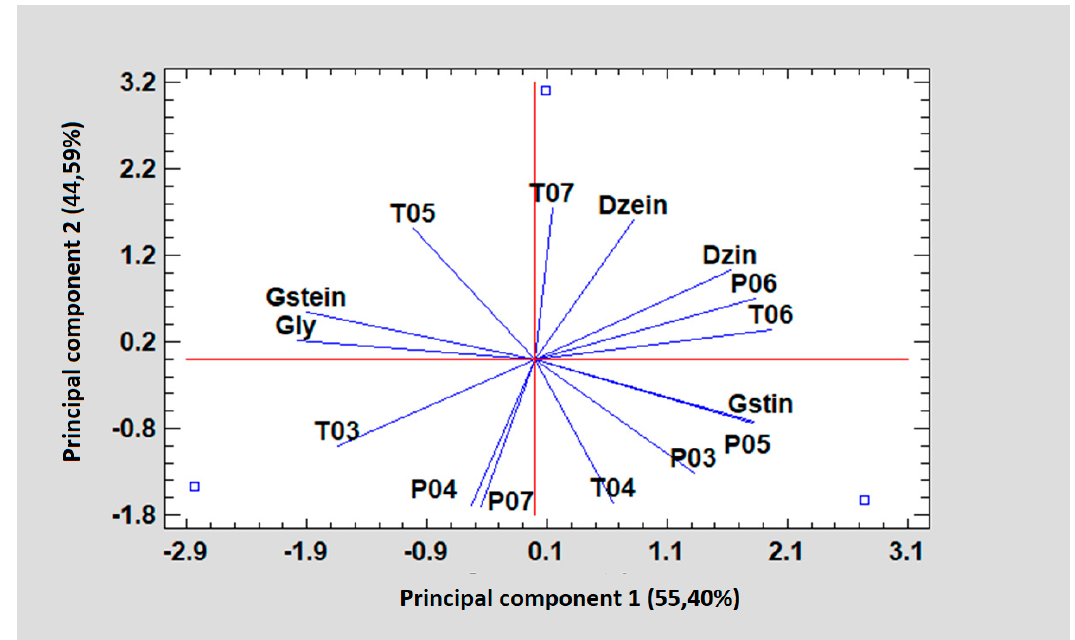
Figure A6. Glycitin concentration in soybeans influenced by field year. Sms: soil tillage system and wct: weed control treatment. The values shown are means ± S.E. Different lowercase letters above the bars indicate significant differences in glycitin concentration between the years undergoing the same treatment, according to Tukey’s HSD test ( P ≤ 0.05).